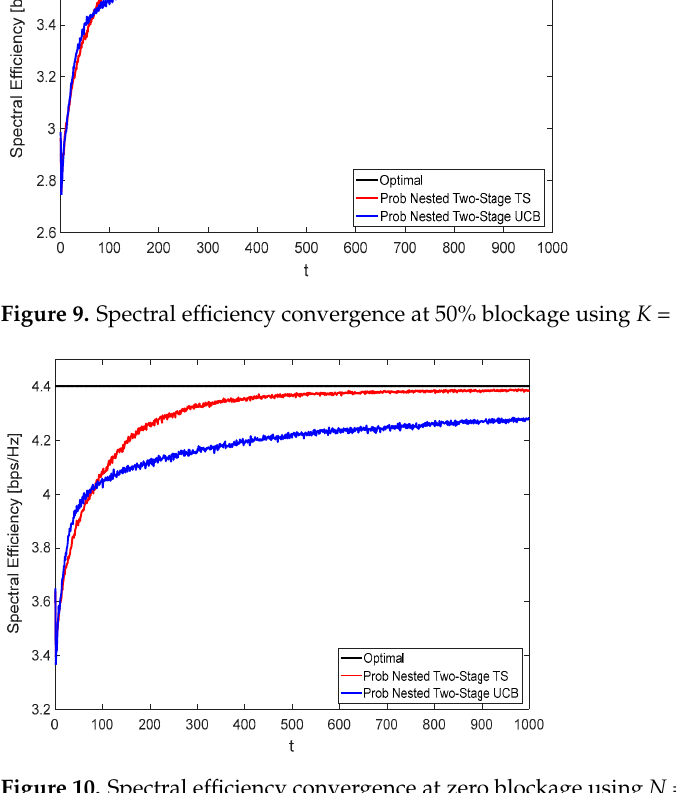
Figure 9. Spectral efficiency convergence at 50% blockage using K = N = M = 16.